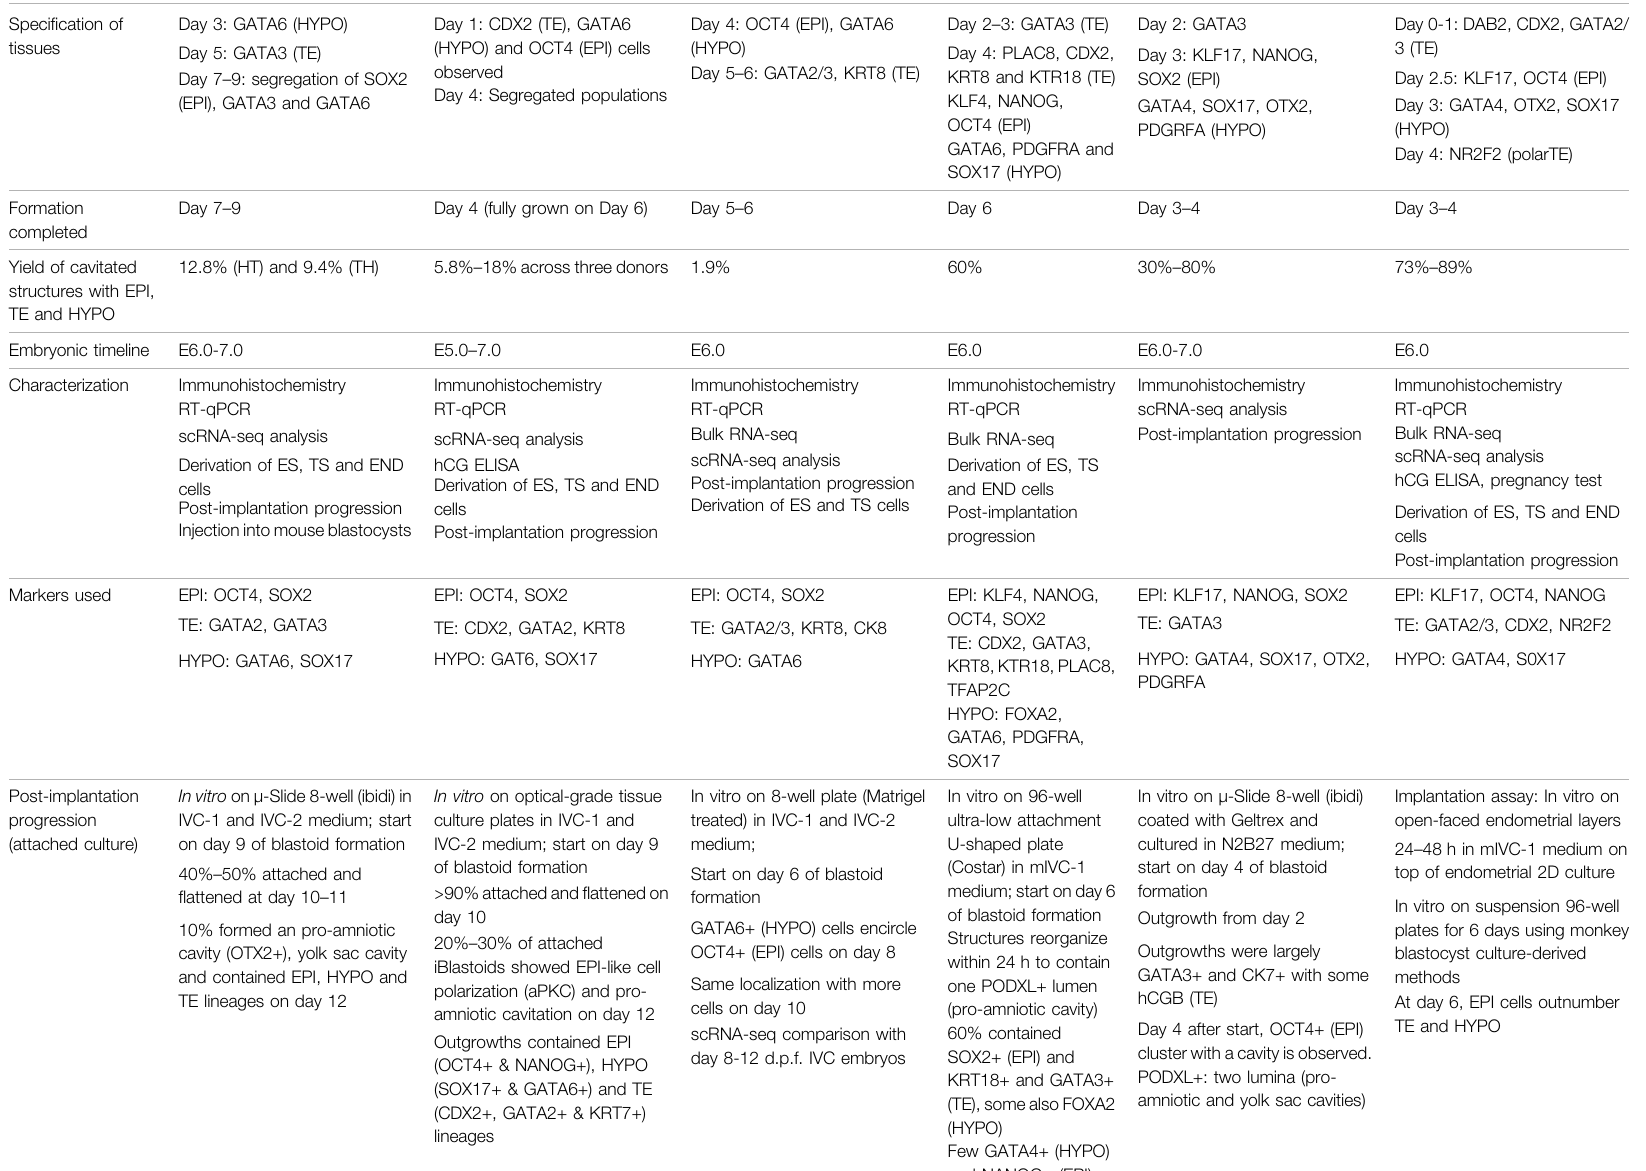
TABLE 2 | ( Continued ) Overview human blastoid protocols, summarizing culture conditions, experimental time lines, blastocyst marker